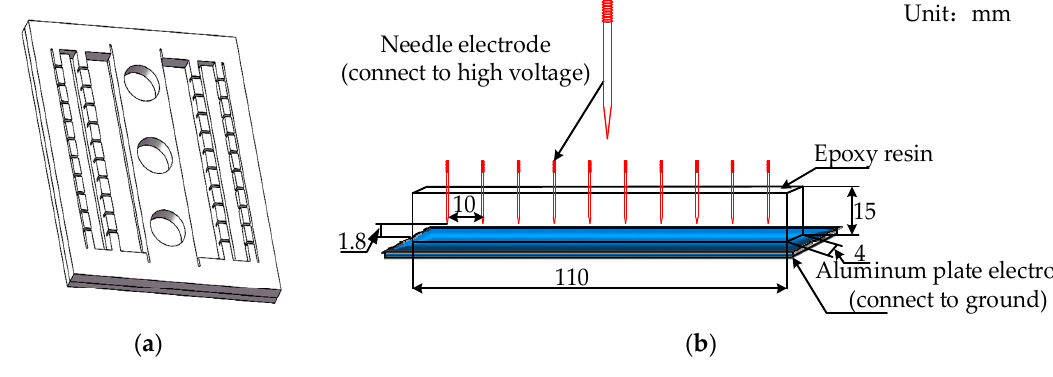
Figure 1. ( a ) Epoxy resin casting mold; ( b ) needle-plate electrode sample.